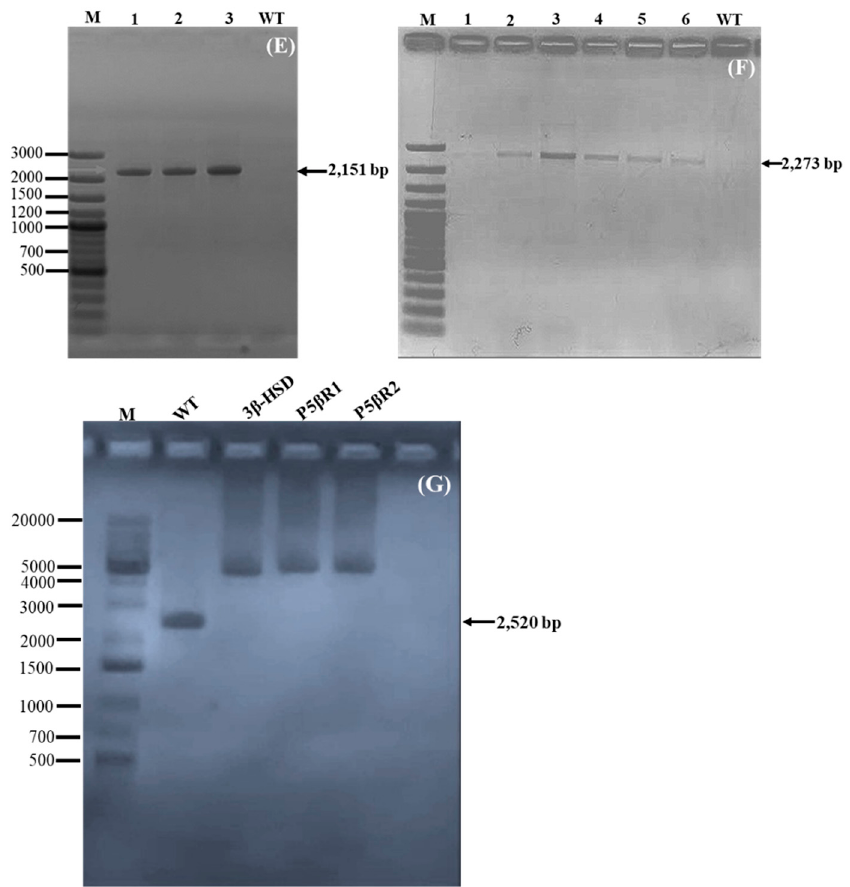
Figure 2. Transgene and homoplasmy confirmation in transplastomic tobacco plants by PCR. ( A ) Confirmation of correct insertion of the 3 β -HSD gene within the plastome on trn R side with 2,082 bp amplified product, ( B ) Confirmation of correct integration of the aadA gene within the transplastomic plants containing 3 β -HSD gene, an amplicon of 2,273 bp was obtained, ( C ) Confirmation of correct insertion of the P5 β R1 gene within the plastome on trn R side with 2,184 bp amplified product, ( D ) Confirmation of correct integration of aadA gene within the transplastomic plants containing the P5 β R1 gene, an amplicon of 2,273 bp was obtained, ( E ) Confirmation of correct insertion of P5 β R2 gene within the plastome on trn R side with 2,151 bp amplified product and ( F ) Confirmation of correct integration of the aadA gene within the transplastomic plants containing the P5 β R2 gene, an amplicon of 2,273 bp was obtained. M: Marker 100 bp plus: Lanes 1,2,3,4,5,6: independent transgenic lines of the 3 β -HSD , P5 β R1 and P5 β R2 . WT: wild-type tobacco as negative control. ( G ) End-to-end PCR for the confirmation of homoplasmy in transplastomic tobacco plants. The expected product length 5065 bp for the gene 3 β -HSD was observed on gel. Amplified fragments of 5455 bp and 5470 bp in sizes were obtained in transplastomic plants containing P5 β R1 and P5 β R1 genes, respectively. A 2520 bp fragment was obtained in WT tobacco plants. No band of WT DNA was detected in transplastomic plants showing that transplastomic tobacco plants contained only transformed state. M: marker; WT: wild-type tobacco plant; 3 β -HSD, P5 β R1, P5 β R1: transplastomic plants containing the 3 β -HSD , P5 β R1 and P5 β R1 genes, respectively. M: Marker 1 kb plus.